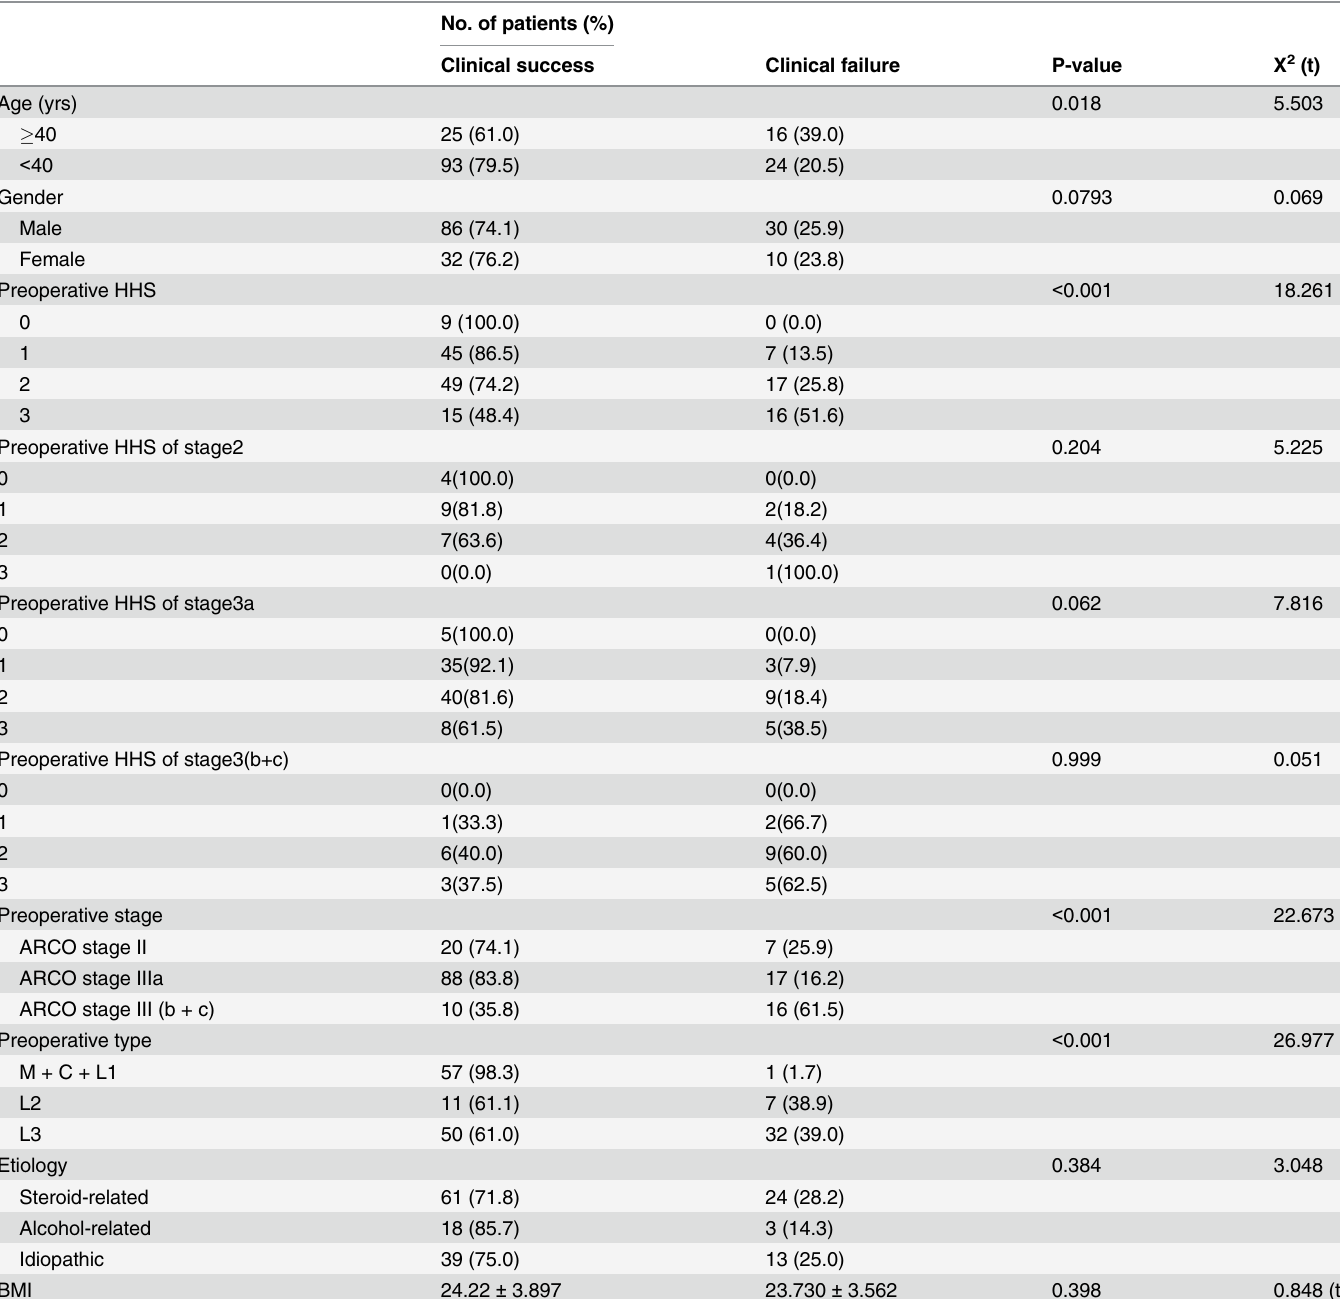
Table 1. Patient